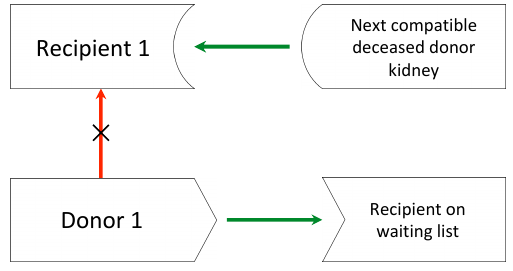
Figure 2. List exchange. Donor 1 donates a kidney to a patient on the waiting list for a deceased donor kidney, and her intended incompatible recipient (recipient 1) receives priority for the next appropriate deceased donor